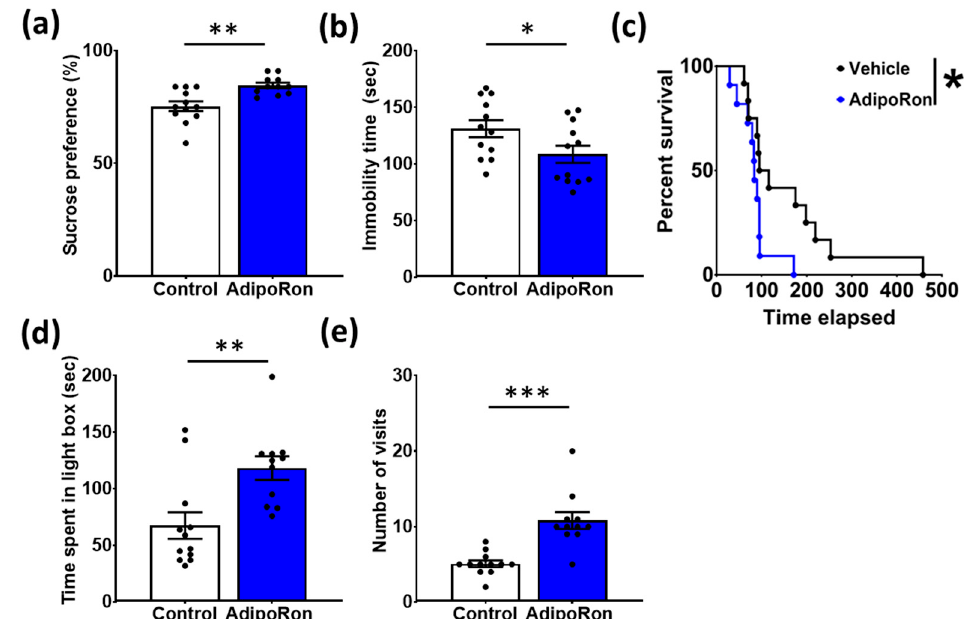
Figure 2. Sub-chronic AdipoRon treatment induced antidepressant- and anxiolytic-like effects. Seven days of AdipoRon treatment significantly ( a ) increased sucrose preference in the SPT and ( b ) reduced immobility time in the FST. Sub-chronic AdipoRon treatment also ( c ) reduced the latency to eat in the NSF test, ( d ) the time spent, and ( e ) the number of visits to the light compartment of the LDB test. Student t-test, * p < 0.05, ** p < 0.01, *** p < 0.001. Data presented as mean ± SEM.